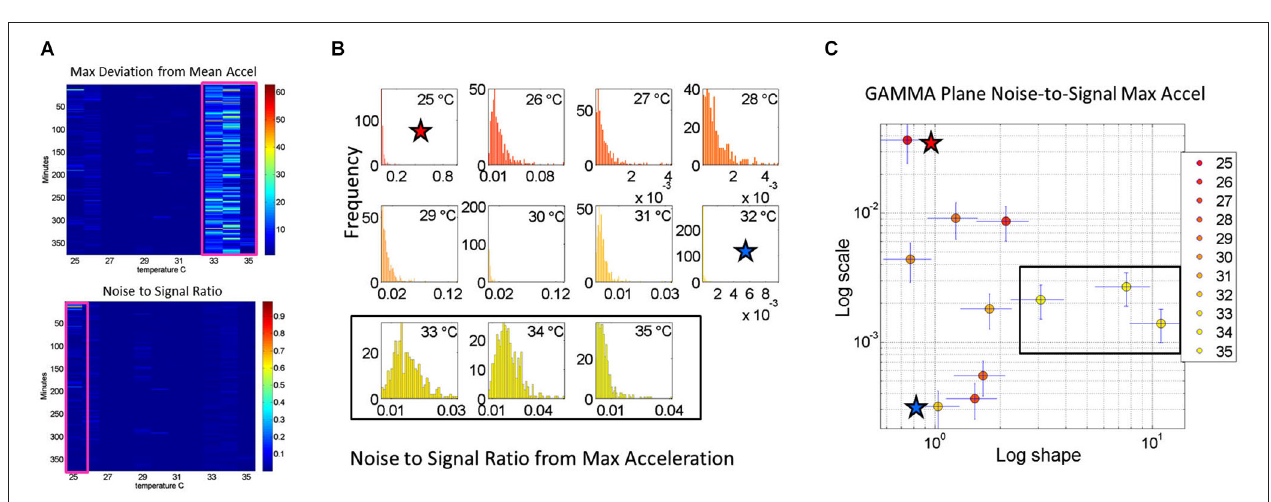
between 33 ◦ C and 35 ◦ C. The highest noise regime occurs at 25 ◦ C while the lowest noise regime occurs at 32 ◦ C. (B) The frequency histograms of the noise-to-signal values are color coded in order of increasing temperature values. Colors are in correspondence to the points on the Gamma plane in (C) . The red star marks the highest noise-to-signal regime while the blue star marks the lowest regime. The temperature intervals containing the highest motion patterns are enclosed by a rectangle. These correspond to the three right most points in the Gamma plane (most systematic patterns), also enclosed within a